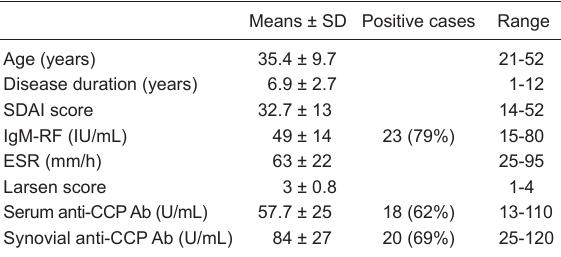
Table 1. Some characteristics of the 29 rheumatoid arthritis